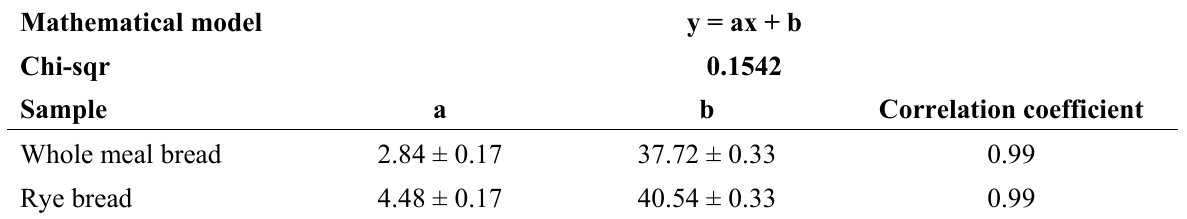
Table 3. Mathematical model of average reflectance as function of storage time.